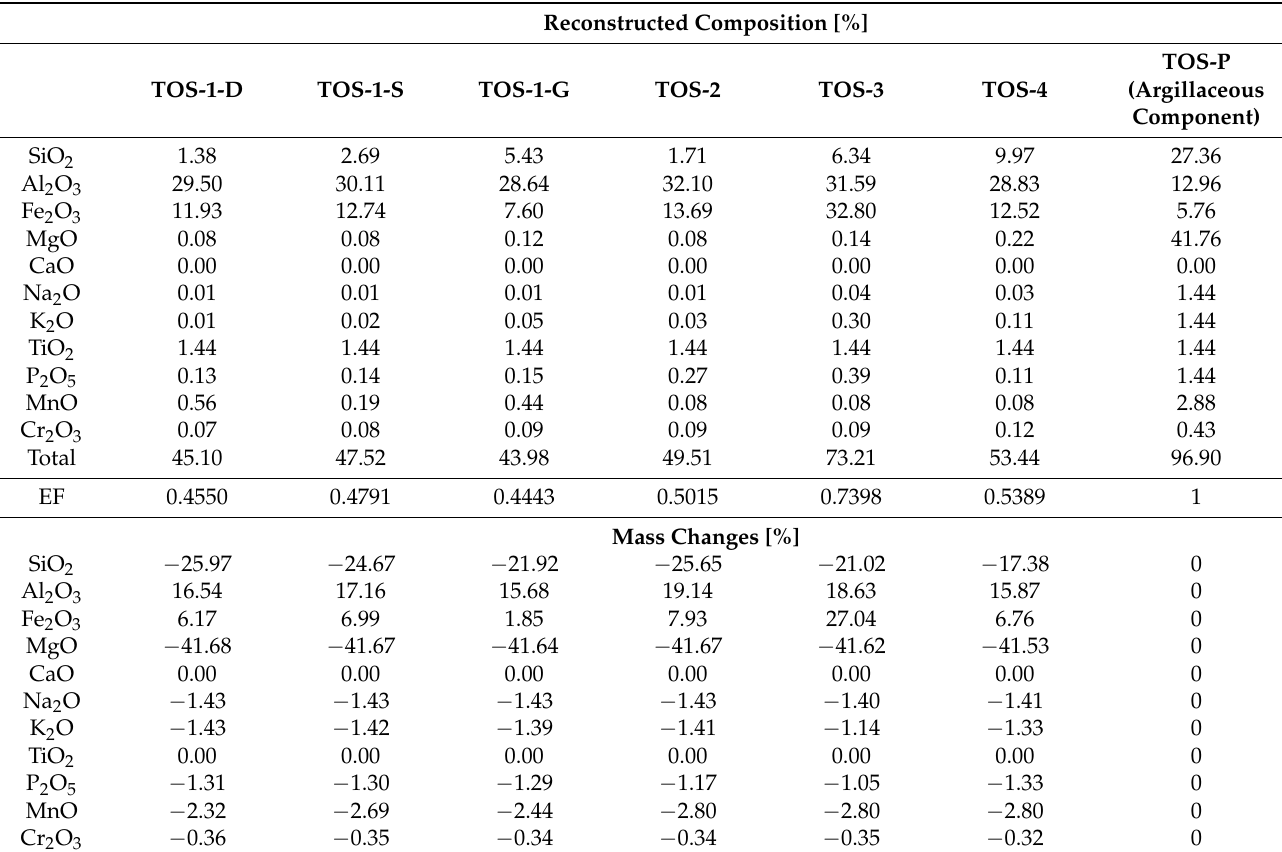
Table 4. Reconstructed composition, enrichment factor (EF), and mass changes for the bauxite samples from the Toši´ci-Duji´ci deposit and the argillaceous component of the bedrock